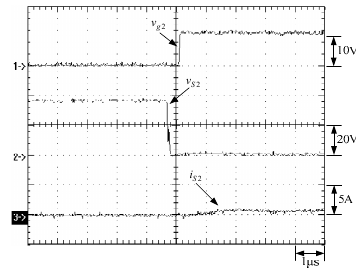
Figure 19. Waveforms pertaining to S 1 at the minimum load: (1) v g 1 ; (2) v S 1 ; and (3) i S 1 .